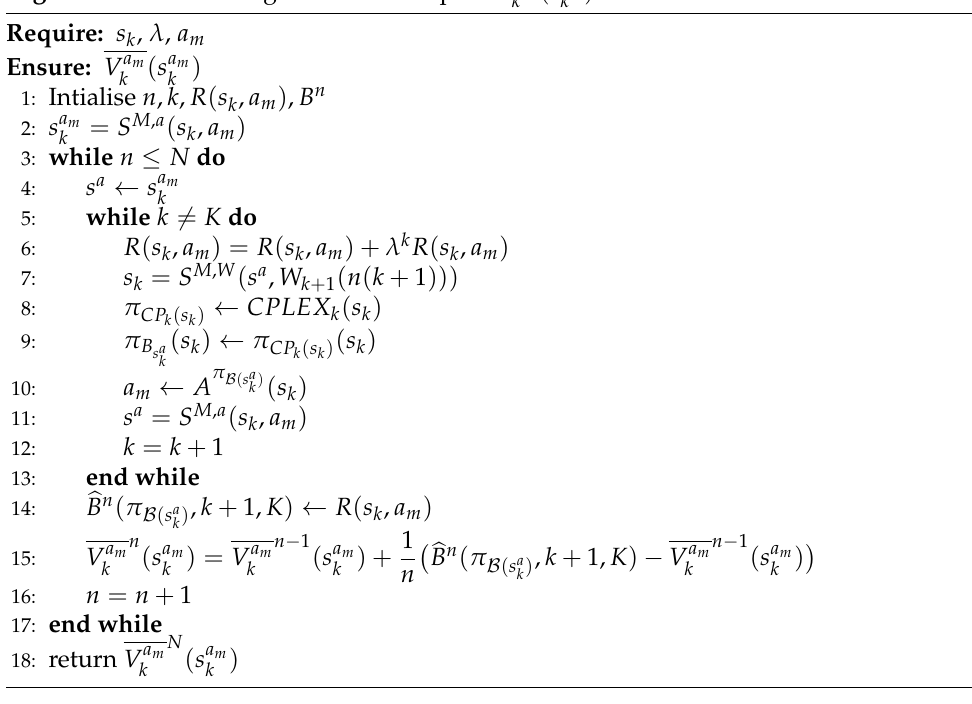
Algorithm 3 Rollout Algorithm to Compute V a m